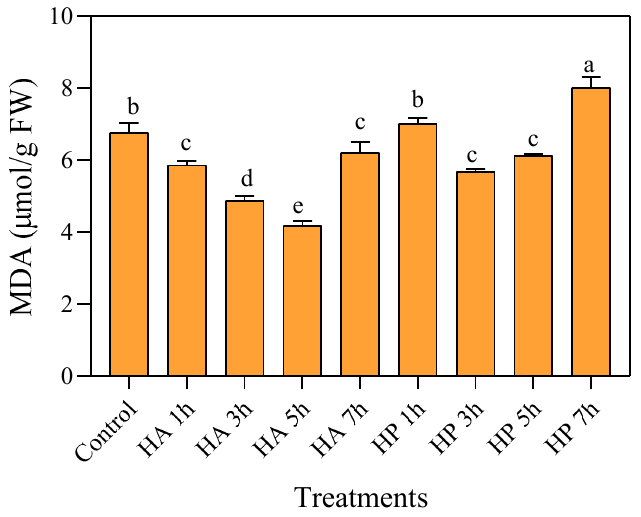
Figure 8. Effect of priming on malondialdehyde content (MDA) and means ( ± SE) followed by the same letter on the bar do not differ significantly based on LSD at p < 0.05.